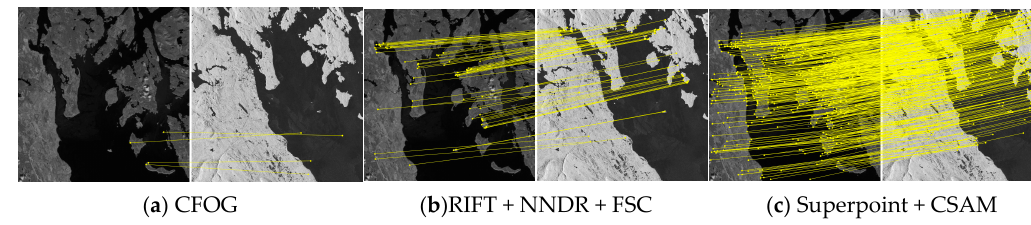
Figure 17. Day–night matching results.